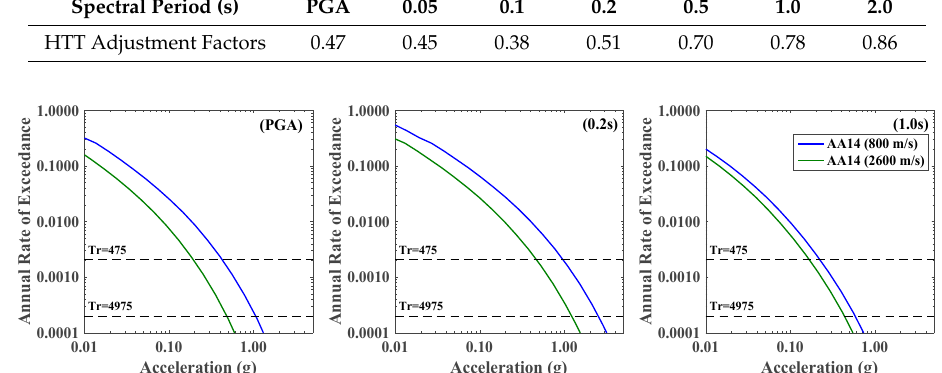
Figure 4. Hazard curves at Euroseistest, for three different spectral periods (PGA, 0.2 s, 1.0 s); blue: standard rock (V S30 = 800 m/s); green: hard rock (2600 m/s), calculated from the hazard curves on standard rock scaled with LA17 host-to-target (HTT) adjustment factors.